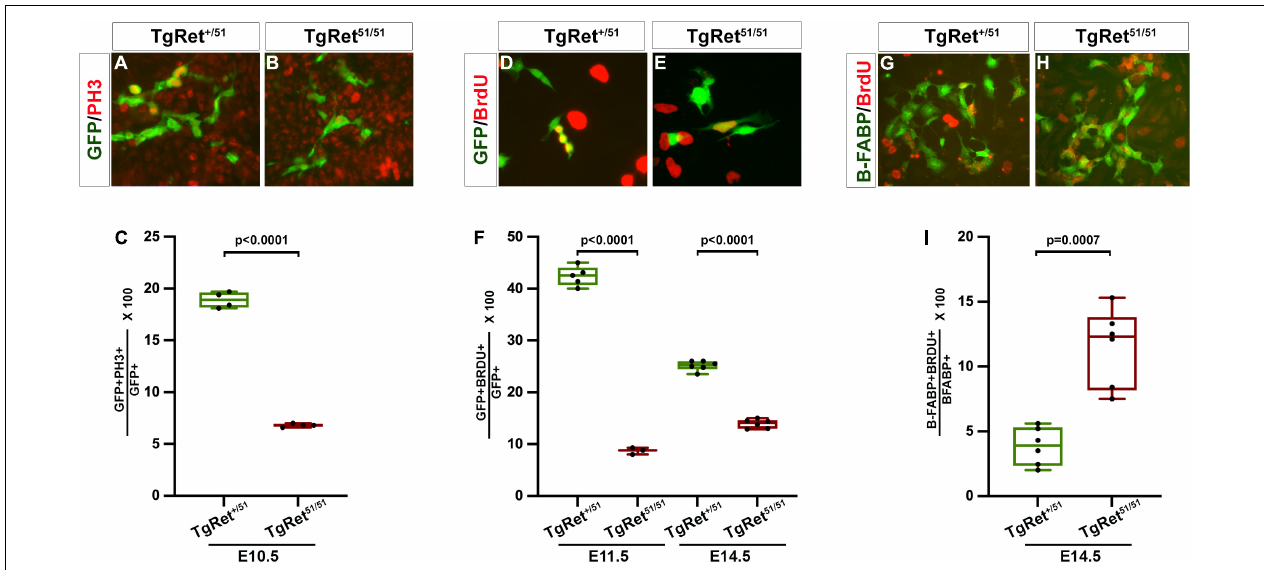
FIGURE 2 | Reduced proliferation of ENCCs homozygous for the Ret 51 / 51 mutation. (A,B) Short term cultures of dissociated gut from control (Tg Ret + / 51 ) and Tg Ret 51 / 51 E10.5 embryos immunostained for GFP and PH3. (C) Quantification of the percentage of double positive cells (GFP + PH3 + {green/red}) in the two genotypes n = 4. (D,E) Short term cultures established from dissociated guts from control (Tg Ret + / 51 ) and Tg Ret 51 / 51 embryos that had previously been exposed to BrdU. (F) The fraction of GFP + BrdU + {green/red} cells was quantified for E11.5 and E14.5 embryos ( n = 5, 6 resp). (G,H) Short term cultures of dissociated gut from control (Tg Ret + / 51 ) and Tg Ret 51 / 51 E14.5 embryos immunostained form B-FABP (green) and BrdU (red) n = 6. (I) Quantification of the percentage of B-FABP + BrdU + double immunostained cells. GFP (green), BrdU (red). Statistical analysis performed by Welch’s t -test. Tg Ret + / 51 represents cells or embryos from genotype Wnt1 cre / + ;R26R stop / YFP ;Ret + / 51 and Tg Ret 51 / 51 represents cells or embryos from genotype Wnt1 cre / + ;R26R stop / YFP ;Ret 51 / 51